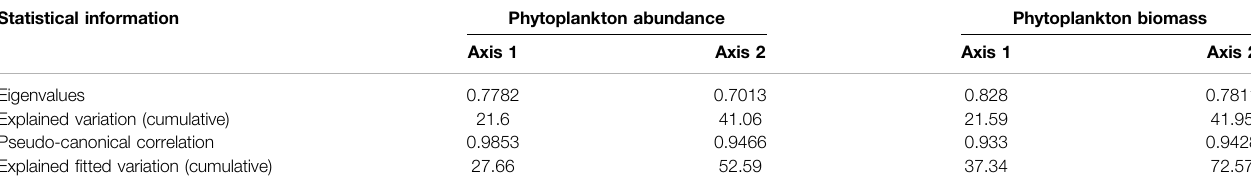
TABLE 3 | Statistical information of CCA analysis of phytoplankton community. Statistical